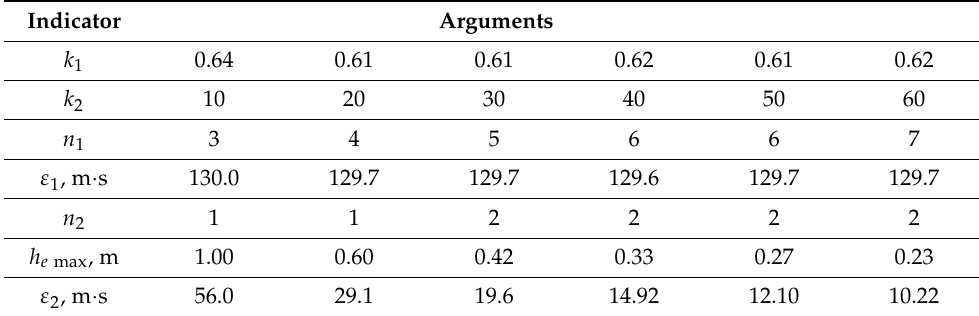
Table 1. Dependence of scale factors on harmonic input